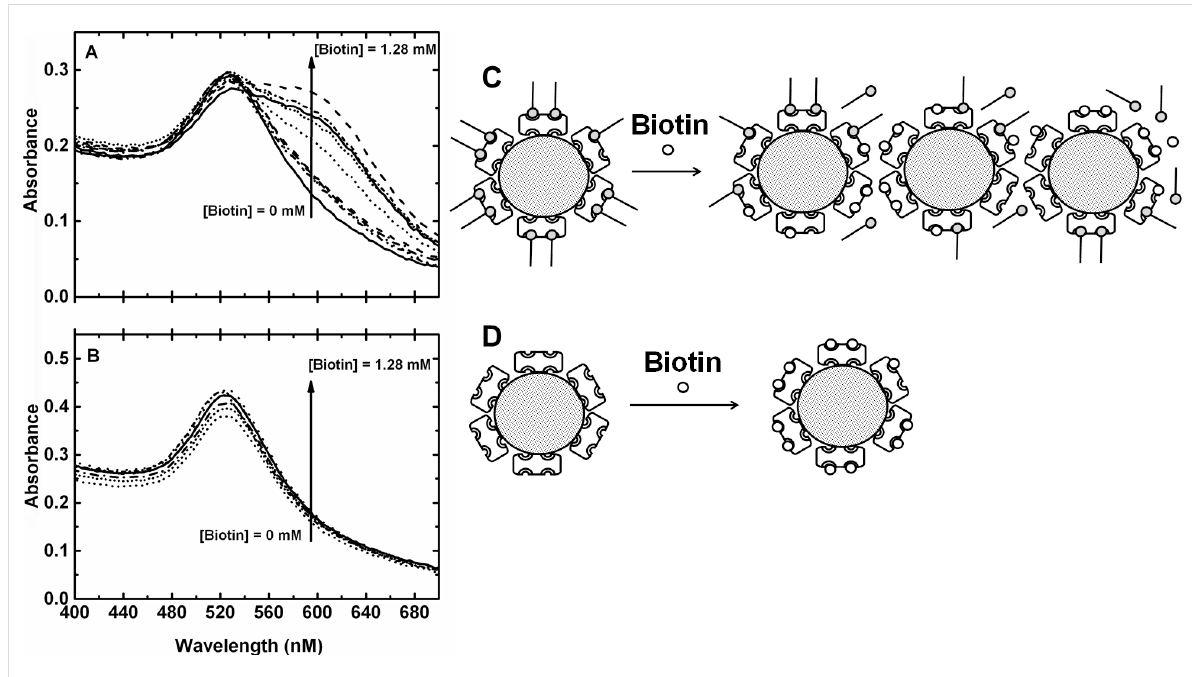
Figure 4: Absorbance spectra (400–700 nm) of AuNP-SA-BiotinDNA (A) and AuNP-SA (B) titred with free-biotin solution. Concentrations of free- biotin, from bottom to top, are 0, 0.01, 0.02, 0.04, 0.08, 0.32, 0.64, 1.28 mM. The effect of free-biotin titration of AuNP-SA-BiotinDNA (C) and AuNP- SA (D).